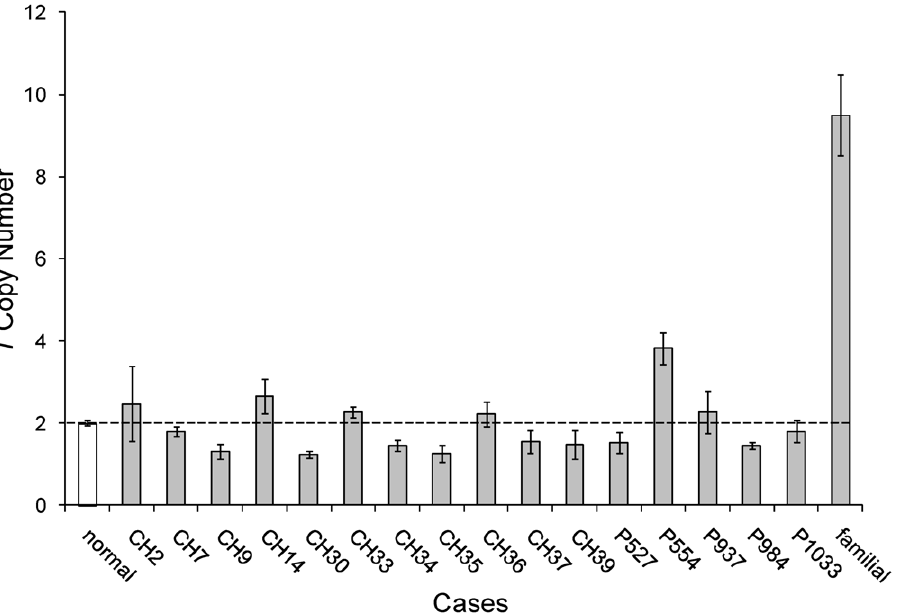
Figure 6. T quantitative real-time PCR. Two primer/probe sets were used to quantitate T (6q27) and MCM7 (7q21.3-q22.1) (n=3). Relative T : MCM7 ratios were normalized against an average ratio established from ten non-chordoma DNA samples (normal). The normalized ratios were corrected for MCM7 copy number from array CGH data and approximate tumor percentage based on histological review. Corrected normalized ratios were multiplied by 2 to obtain the absolute T copy number. The dashed line represents a normal copy number of 2.